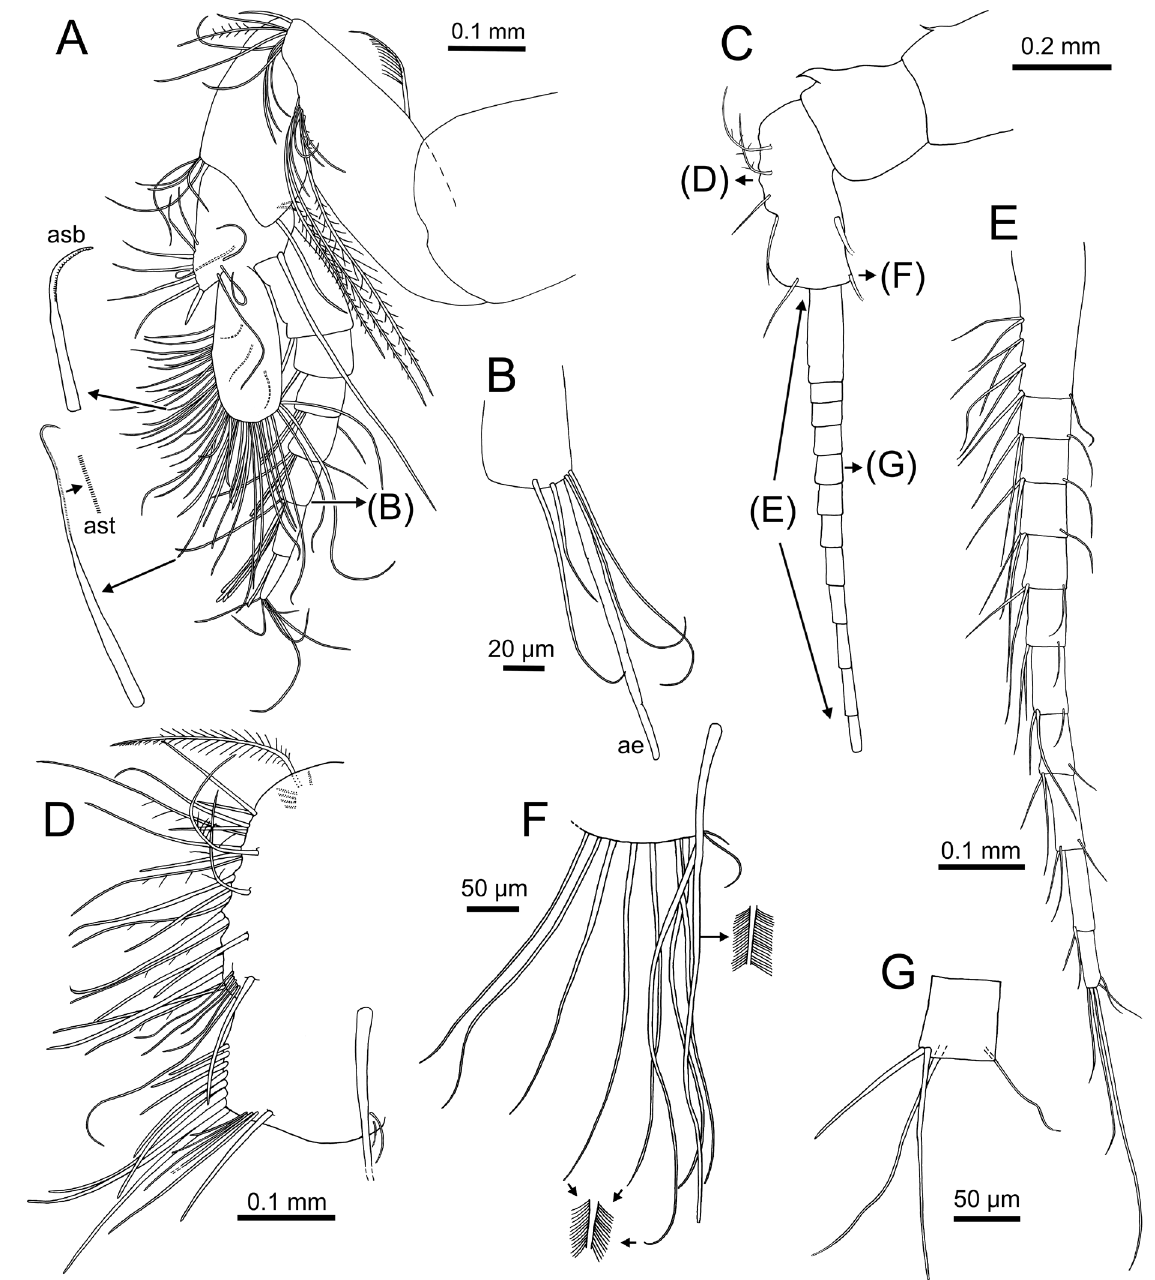
Fig. 11. Sarsinebalia ledoyeri sp. nov. Postovigerous female, paratype (MNCN 20.04/13708). A . Antennule, lateral view. B . Antennule, flagellum, fifth article. C . Antenna, lateral view, outline. D . Antenna, peduncle, third article, lateral view. E . Antenna, flagellum. F . Antenna, peduncle, third article, distal margin plumose setae. G . Antenna, flagellum, fifth article. A, C: letters in brackets refer